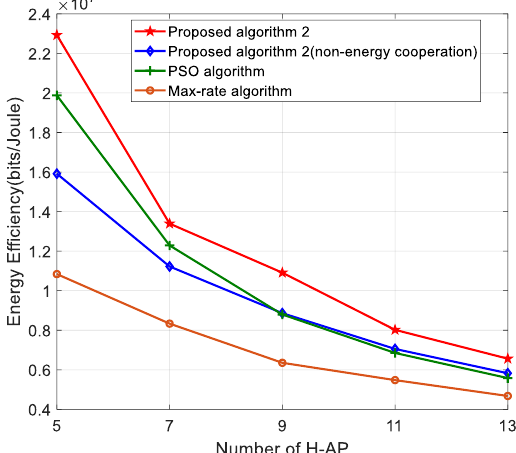
Figure 5. Energy efficiency versus the number of H-APs for different algorithms. Figure 5. energy efficiency versus the number of H-APs for different algorithms.